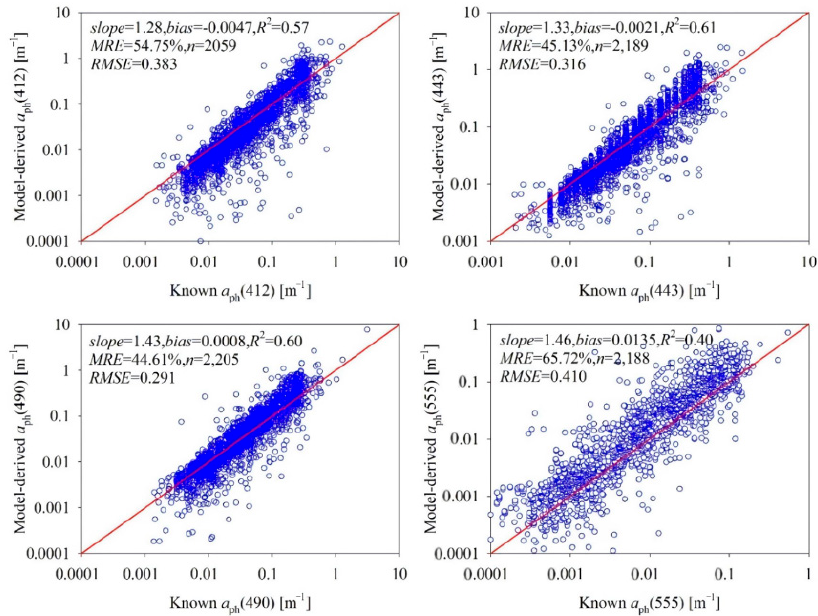
Figure 7. Accuracy of the QAA model in deriving phytoplankton coefficients of absorption.